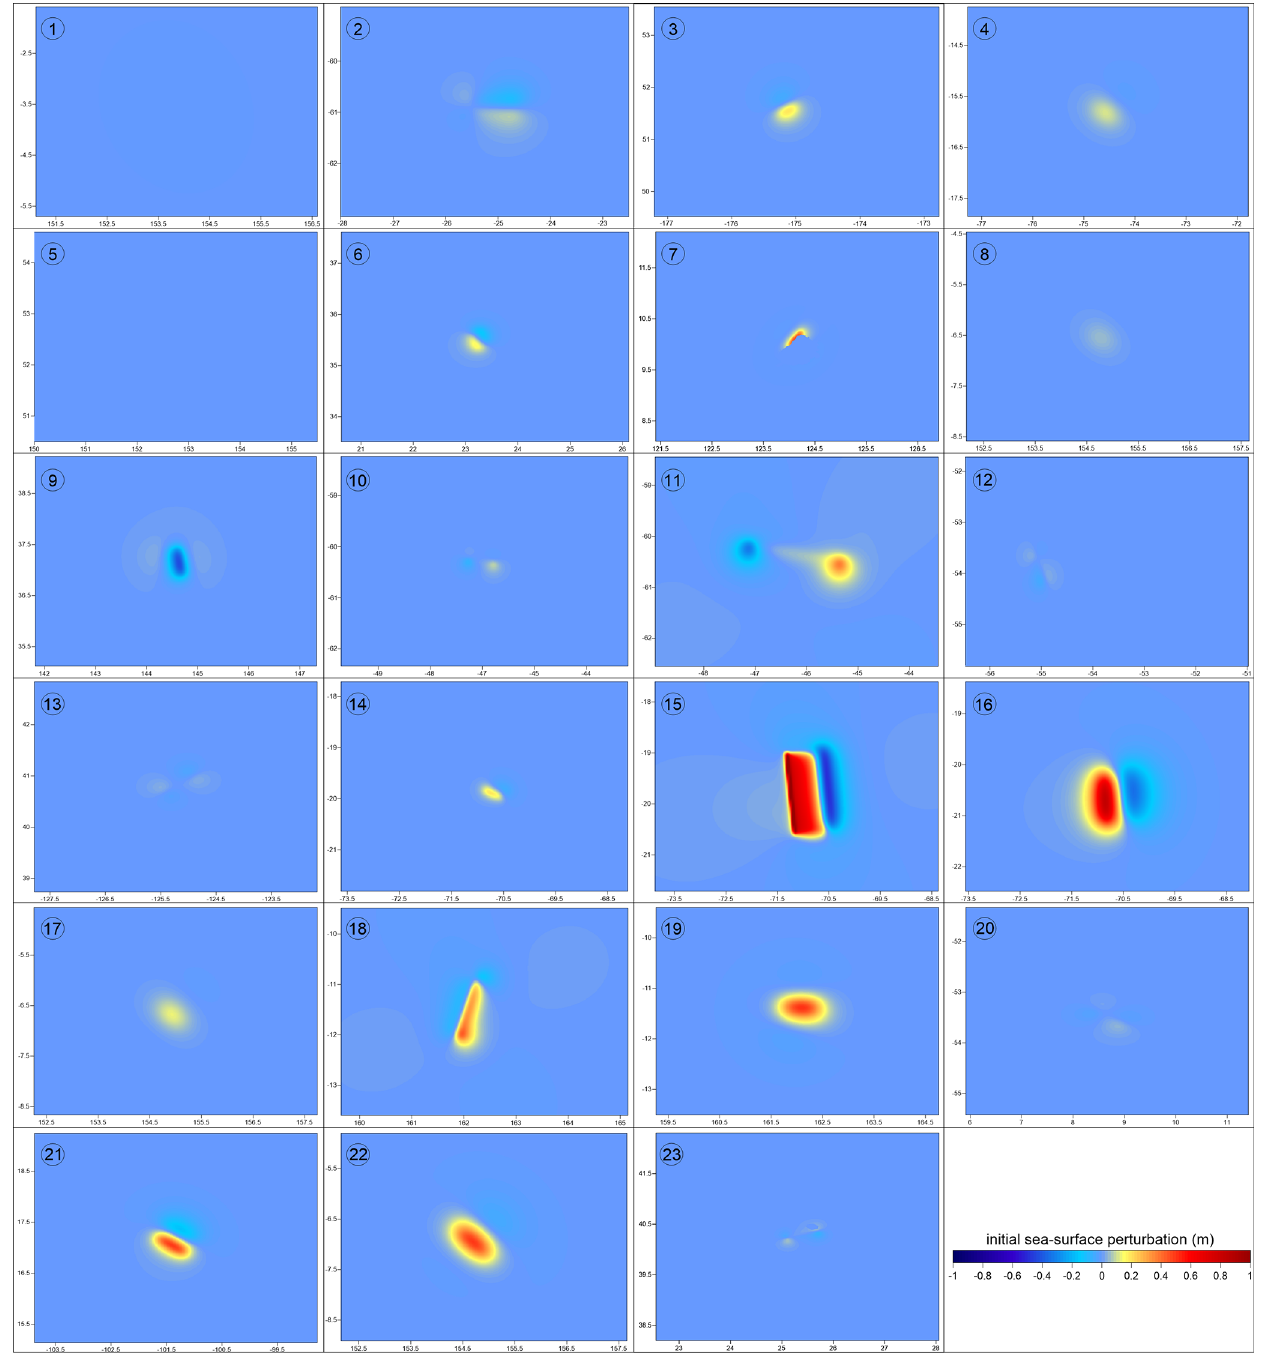
Figure 6. Simulated initial sea-surface perturbations caused by the studied 23 submarine earthquakes. The number in the top-left corner of each figure corresponds to the event’s number indicated in Table